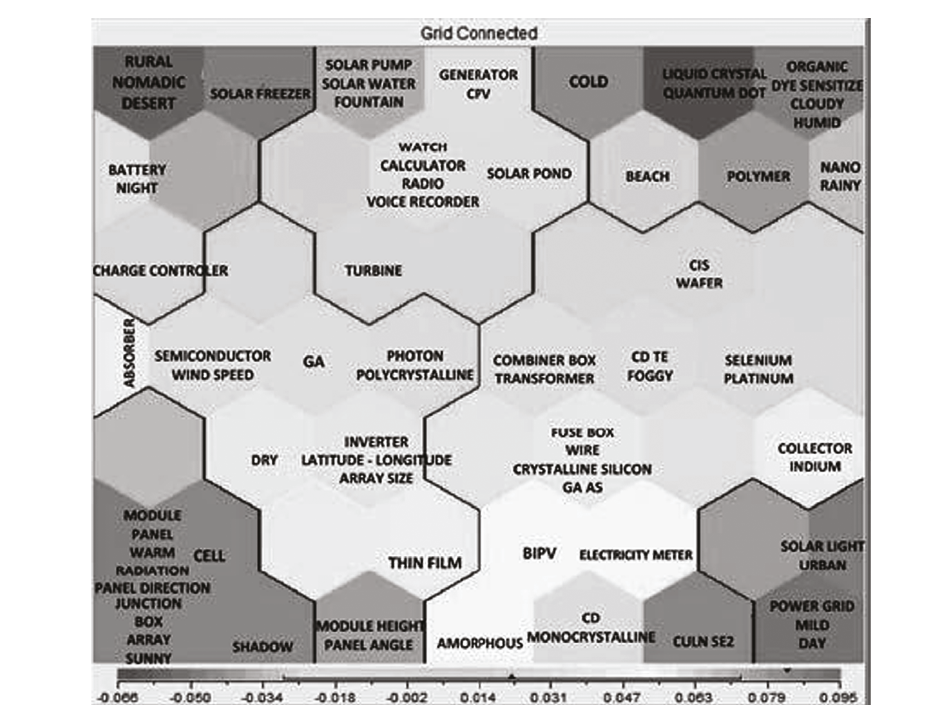
Figure 8: Feature map of the process connected to the network.